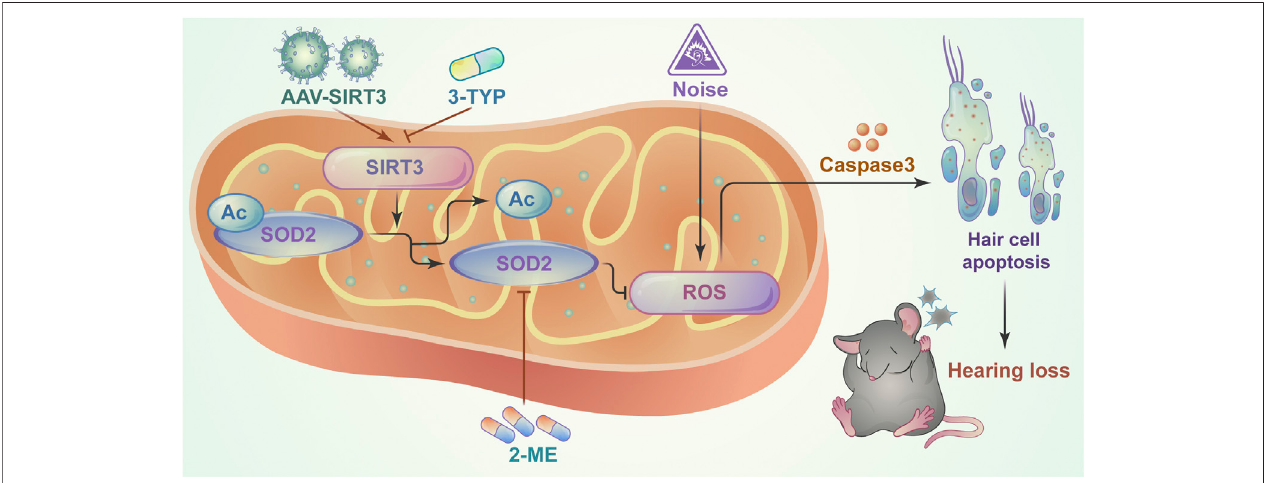
FIGURE 7 | Schematic model showing the critical role of mitochondrial oxidative stress in NIHL model hair cells and the protective role of SIRT3/SOD2 signaling. SIRT3 deacetylates and activates SOD2, reducing reactive oxygen species production and thereby ameliorating noise-induced hair cell damage.